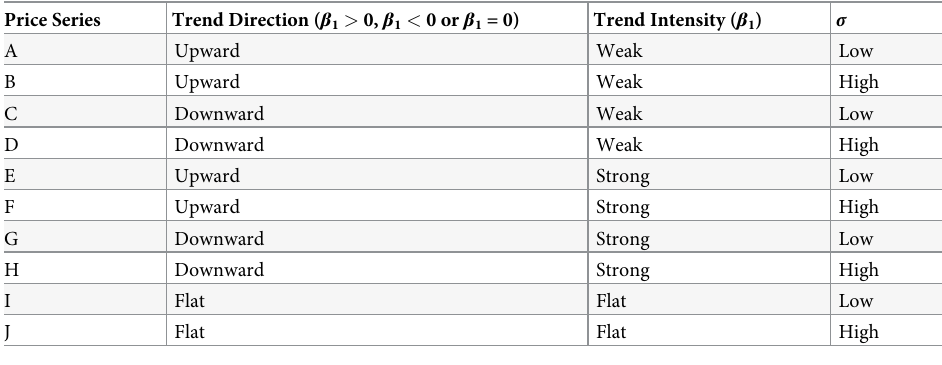
Table 3. Properties of the generated price